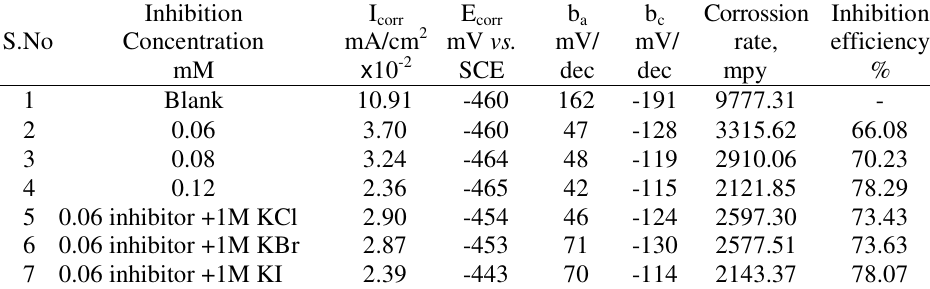
Table 5. Potentiodynamic polarization parameters for the corrosion of mild steel in 1 M H SO with and without (02TD). 2 4